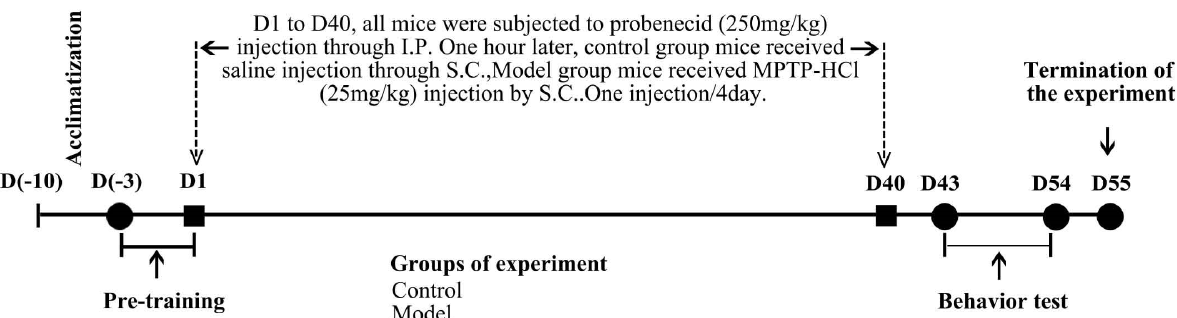
Figure 11. Schematic of the experimental